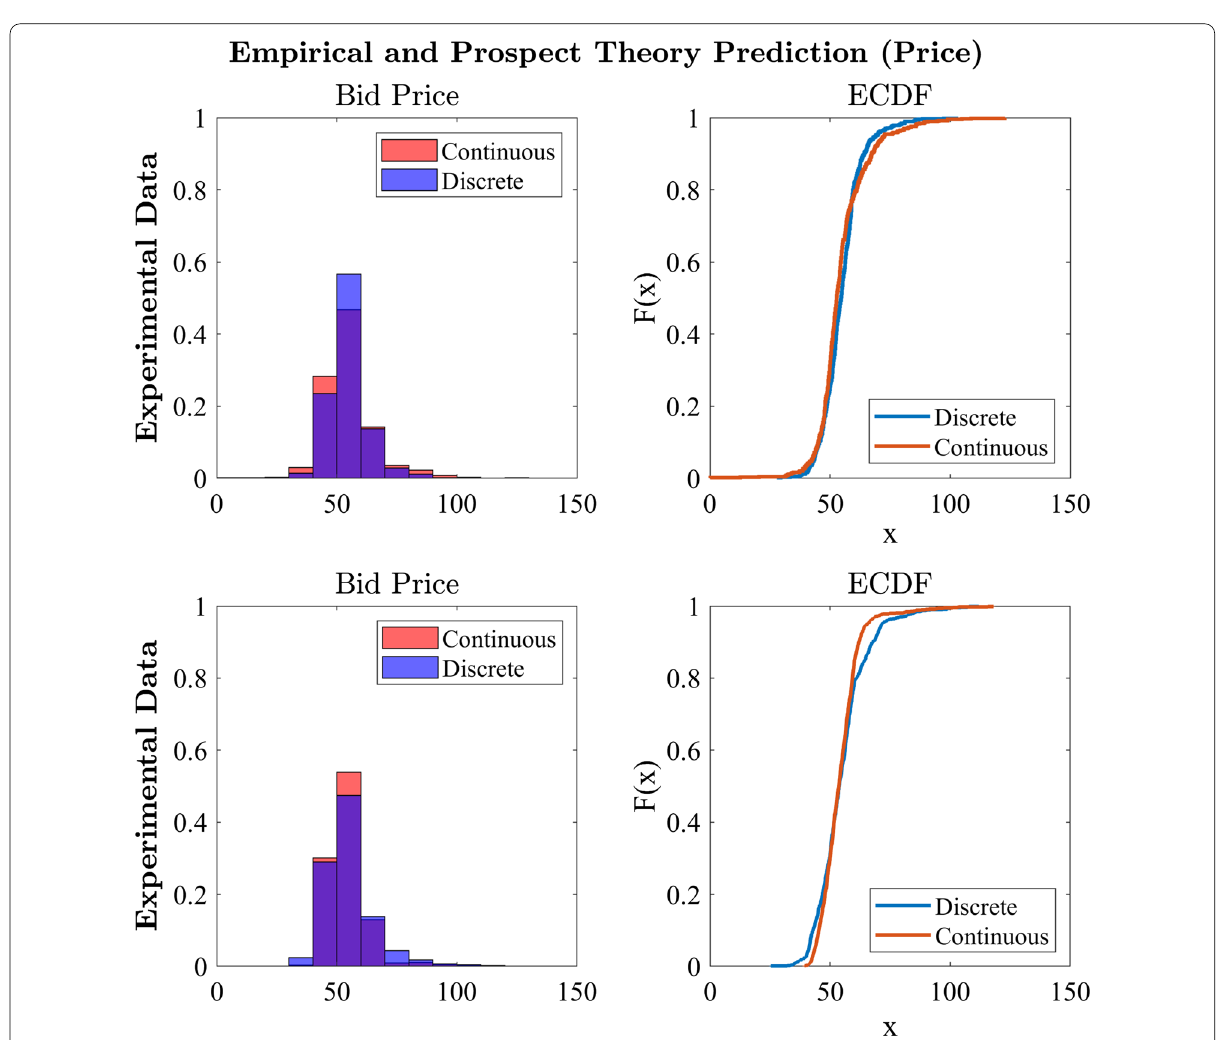
Fig. 14 Empirical data (top) and prospect theory predictions (bottom) of price of the winning